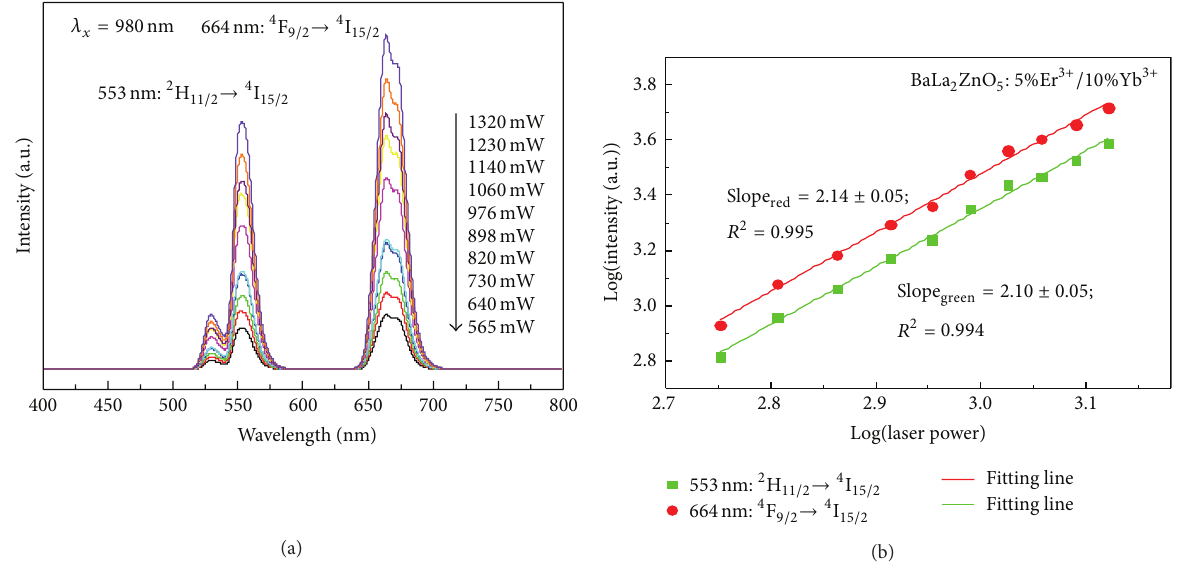
Figure 4: UC emission spectra of BaLa 2 ZnO 5 :0.05Er 3+ /0.10Yb 3+ with different pumping power (a) and dependence of green and red UC emission intensities upon pumping power (b).